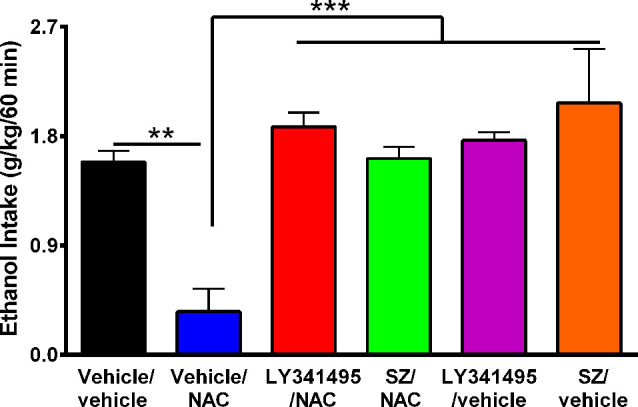
The N-acetylcysteine (NAC)–induced inhibition of binge-like ethanol intake in the first 60 min of ethanol reaccess was fully blocked by inhibition of the glutamate mGlu2/3 receptor or the xCT-cystine/glutamate exchanger. Data showed ethanol intake of all groups during the first 60 min of ethanol reaccess. Analysis of variance of data indicates significant effect of treatments vs. vehicle/vehicle group (F(5,23) = 11.56, ***P < 0.001). Post hoc analysis indicated that NAC (100 mg/kg per day for 4 days) induced a significant reduction of the alcohol relapse-like drinking (vehicle/NAC group compared to vehicle/vehicle group **P < 0.01), whereas pretreatment with LY341495, an antagonist of mGlu2/3 receptors, or sulfasalazine (SZ), an inhibitor of xCT-cystine/glutamate exchanger fully prevented the NAC-induced reduction of alcohol relapse (LY341495/NAC group vs. vehicle/NAC group ***P < 0.001 and SZ/NAC group vs. vehicle/NAC group ***P < 0.001). Data are presented as mean ± SEM, n = 6 rats per experimental group.